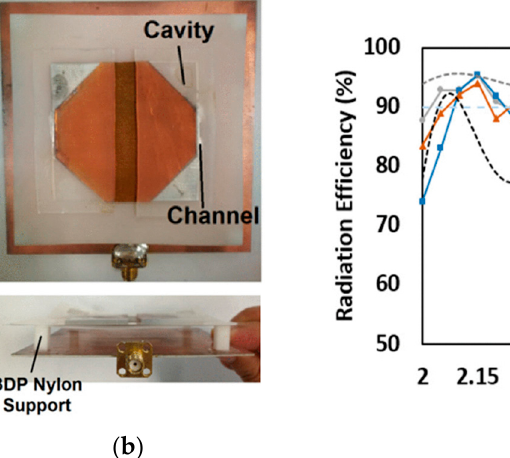
Table 2. LM Antenna patterning techniques based on soft / photolithography fabrication method. Abbreviations: LCP, liquid crystal